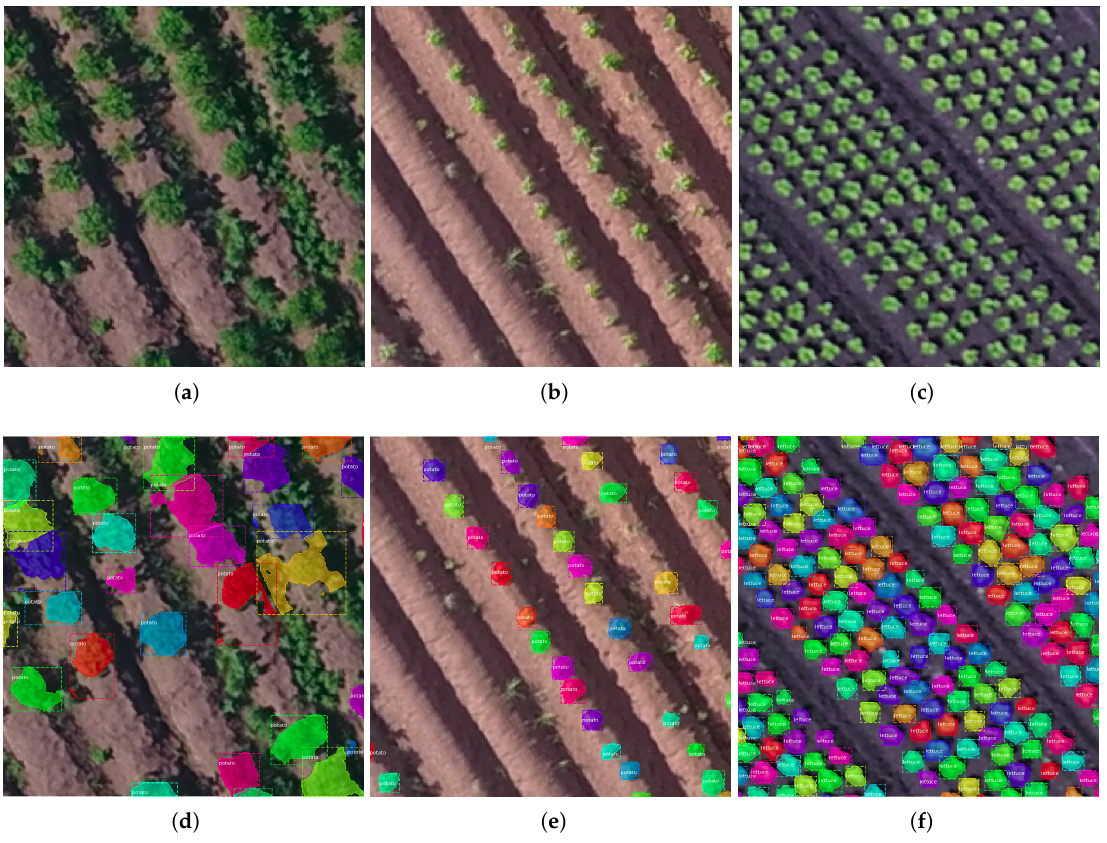
Figure 2. Three examples of remote sensing imagery of low density crops ( a – c ), as well as their corresponding counting and sizing annotations ( d – f ). The ( a , d ), ( b , e ) are potato fields, respectively, from POT_CTr and POT_RTr while ( c , f ) are from a lettuce field from LET_RTr. Please note that the colour coding is random, apart from the fact that each single-colour blob represents a single plant, while the green area not marked (especially in the top image) signifies irrelevant to the crop vegetation